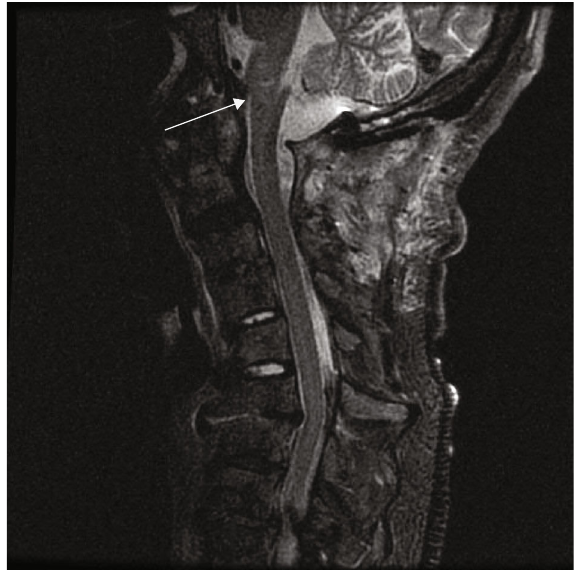
Figure 5: Postoperative MR cervical T2-weighted sagittal image demonstrates resolution of the cervicomedullary compression and caudal medullary cyst.